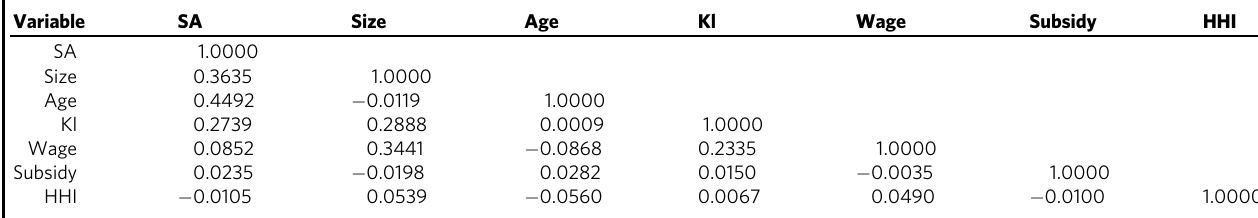
Table 3 Correlation matrix of main